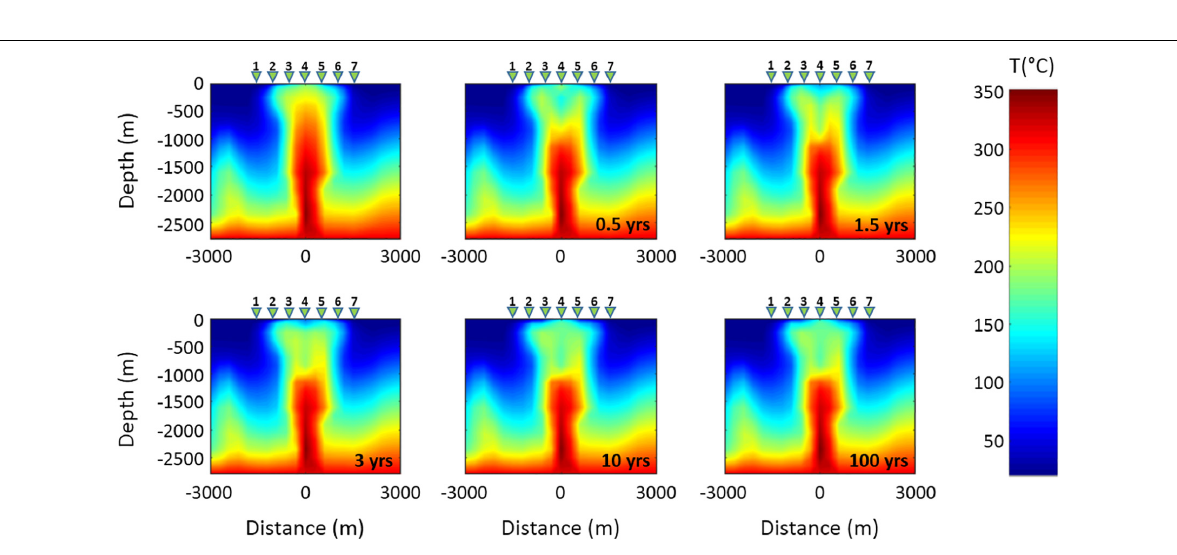
Frontiers in Earth Science |